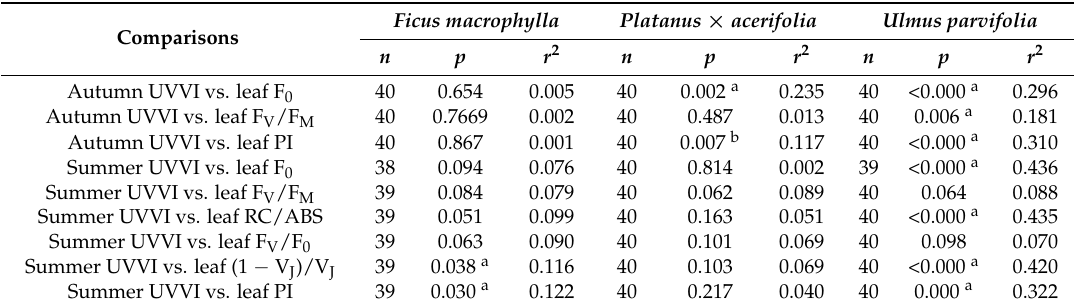
Table 2. Summarized results from simple linear regression analyses comparing autumn and summer leaf fluorescence with autumn and summer urban tree visual vitality index in Ficus macrophylla, Platanus × acerifolia , and Ulmus parvifolia .